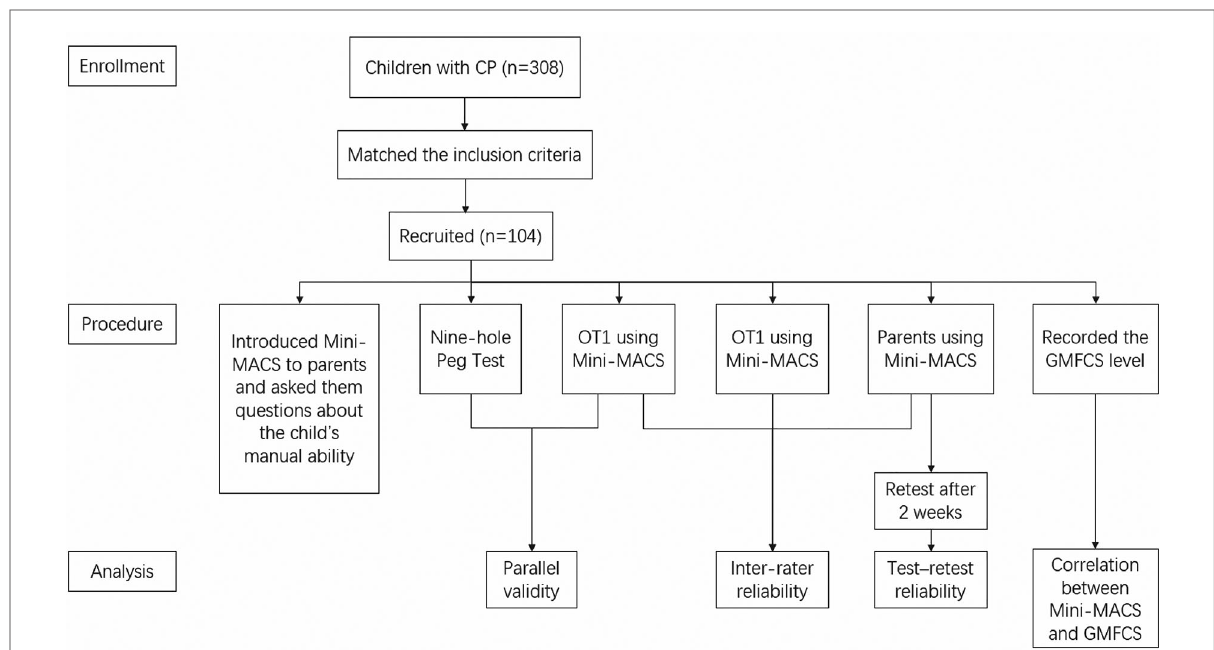
FIGURE 1 Study fl ow. CP, cerebral palsy; Mini-MACS, Mini-Manual Ability Classi fi cation System; GMFCS, Gross Motor Function Classi fi cation System; OT, occupational therapist; PT, physical